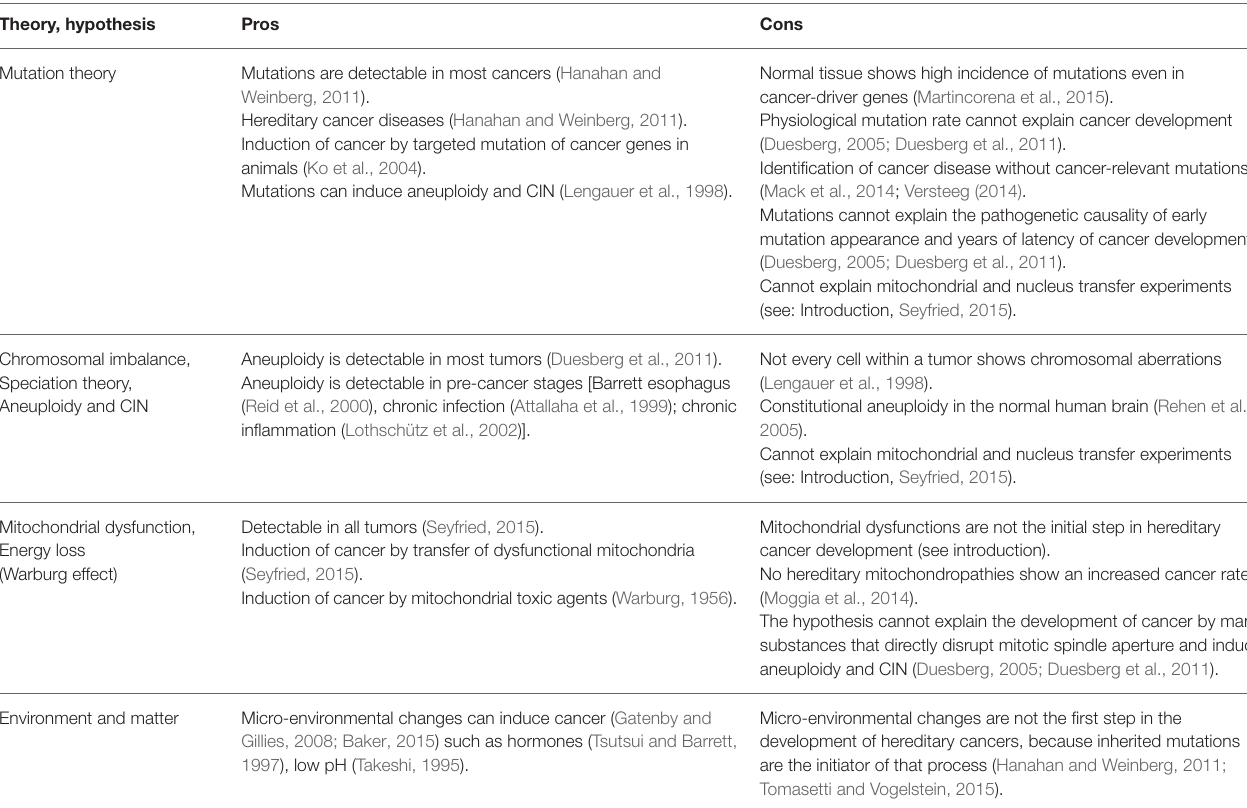
TABLE 1 | Pros and cons of different theories and hypotheses indicate that no one theory can claim to be the exclusive cause of cancer initiation and progression. Theory, hypothesis Pros Cons Mutation theory Mutations are detectable in most cancers (Hanahan and Weinberg,